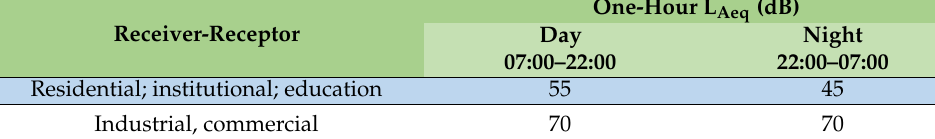
Table 4. Excerpt from the table “SEA objectives and indicators” related to noise. (Source: SEA for the Urban Plan of the Maestrale Ring wind farm). Zone Purpose of the Space Day and Evening (Guidelines for Community Noise, World Health Organization (WHO),